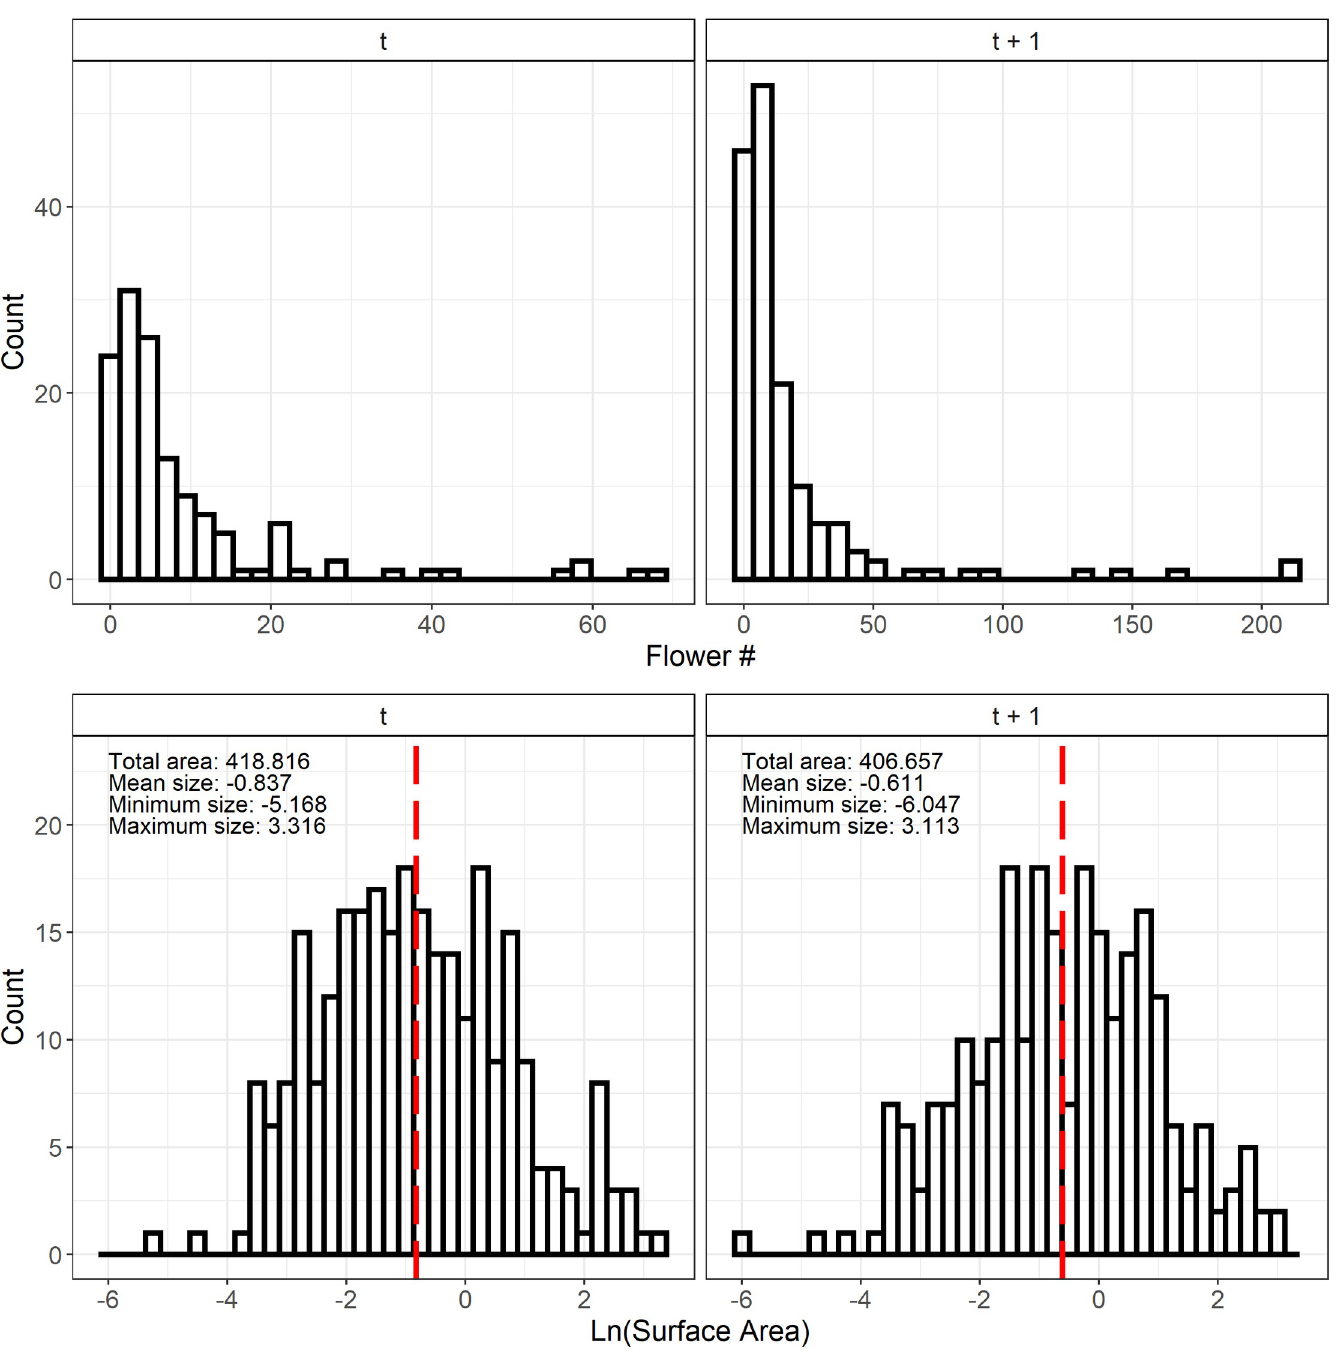
Fig 2. Frequency distributions for flowers and ramets. Top row: Frequency distributions of the number of flowers at time t and t+1 . Bottom row: Frequency distributions of ramet size at t and t+1 . Red dashed vertical lines denote the mean ramet size for each sampling time, and minimum and maximum sizes are indicated in the top left